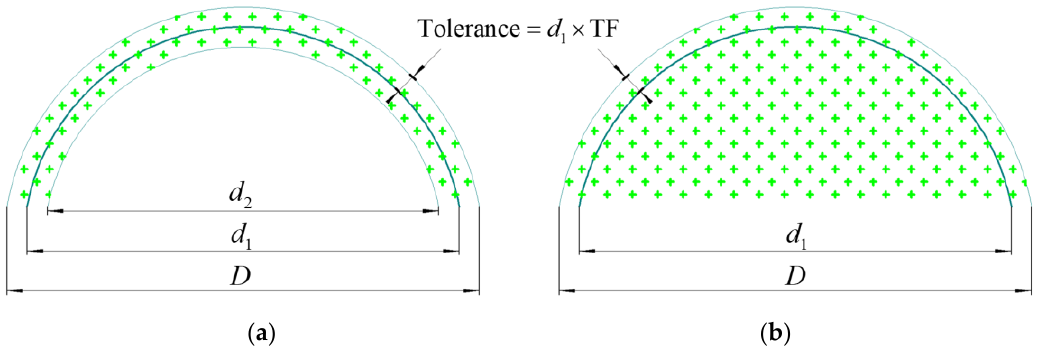
Figure 6. Node search criteria: ( a ) shell search; ( b ) solid search. Where d 1 is pitch circle diameter (PCD), and D and d 2 indicate the search range. D = d 1 × (1 + 2 × TF), d 2 = d 1 × (1 – 2 × TF).